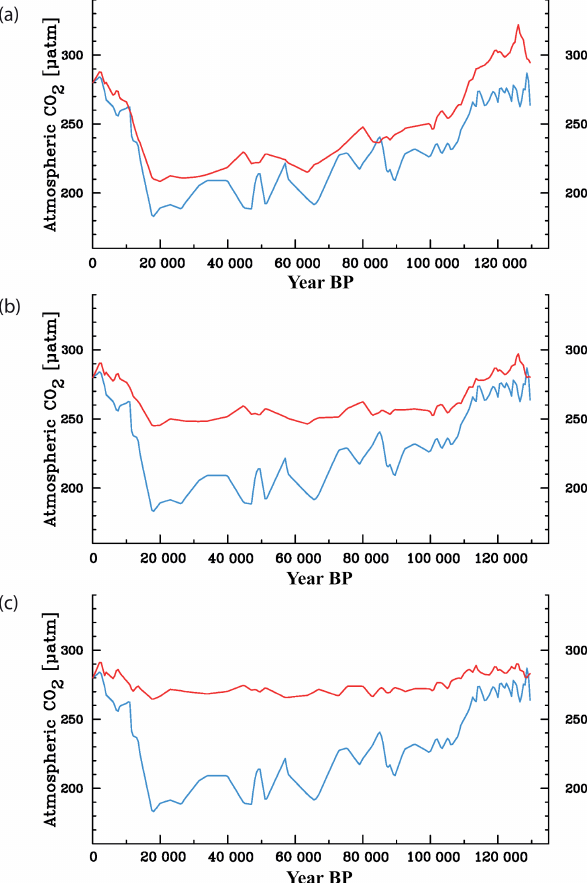
Figure 10. Goodness of fit for the full rank (rank 8) (a) , rank 7 (b) , and rank 6 (c) solutions (blue line: observations; red line: inverse modelling result). The example is for the predicted evolution of at- mospheric CO 2 . The observed record comes from the Vostok ice core, Antarctica (Barnola et al., 1987). The rendering of realistic parameter variations in the rank deficient solutions is accompanied by a strong reduction in goodness of